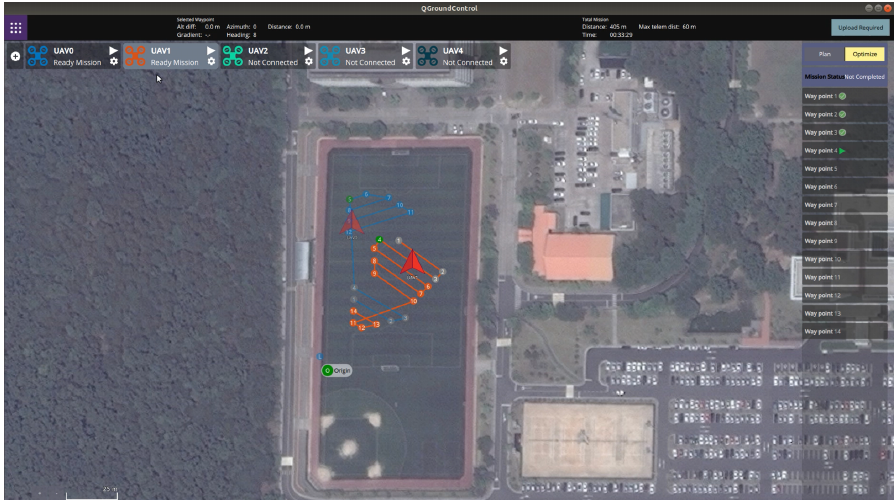
Figure 14. Waypoint status shown in